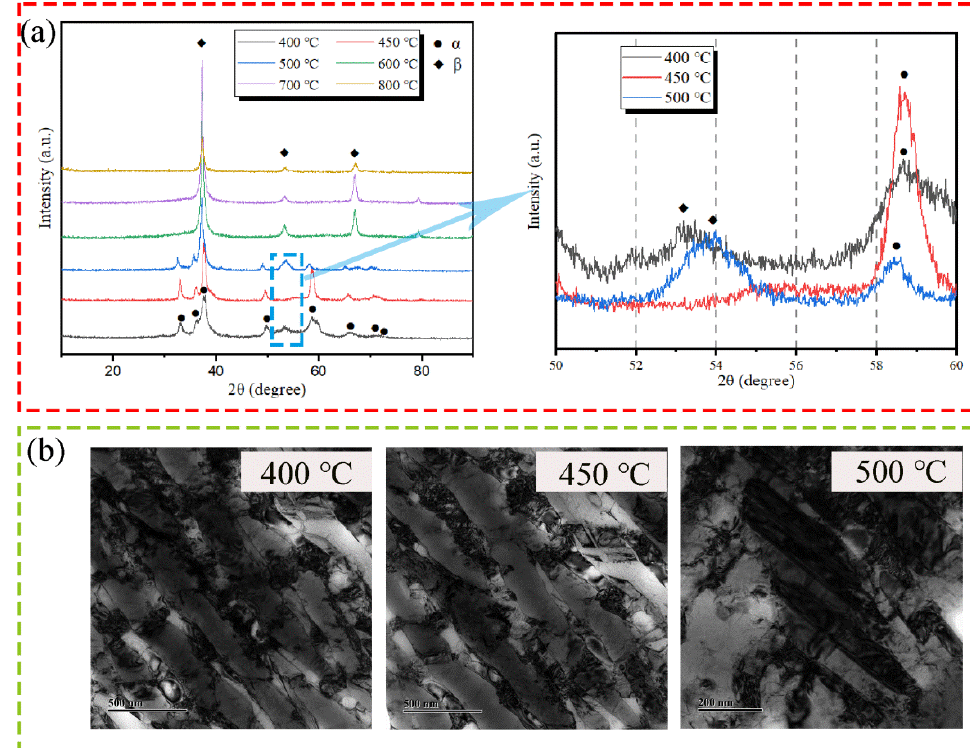
Figure 2. ( a ) XRD pattern of the annealed Zr–Ti–8V alloys; ( b ) TEM images of the Zr–Ti–8V annealed alloy at 400 °C, 450 °C, and 500 °C.